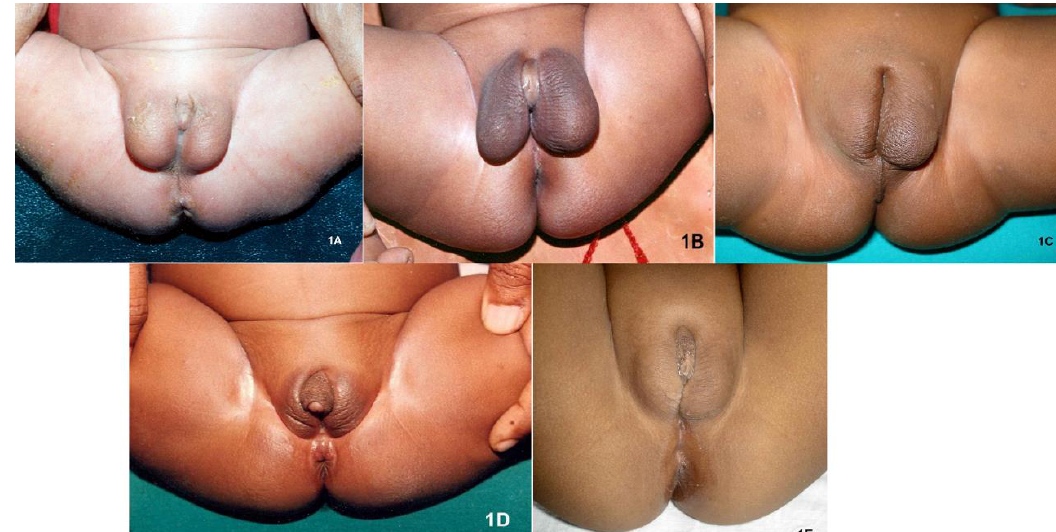
Figure 1: Appearance of external genitalia is no guide to assignment of sex in neonates. Despite similar appearance of the external genitalia the diagnosis and management in each of them are significantly different. (1A). 5-alpha reductase deficiency (46XY, bilateral testes) requires male assignment as the penis will enlarge at puberty; (1B) Severe hypospadias is otherwise an established male in all aspects; (1C). High risk of cancer in mixed gonadal dysgenesis (left testis and right ovary) requires early gonadectomy and female sex assignment; (1D). Congenital adrenal hyperplasia (46XX, bilateral ovaries) is usually assigned to female sex but severe androgen imprinting may require male assignment; (1E). Complete androgen insensitivity syndrome (46XY, bilateral testes) requires female sex assignment due to poor androgenization of body and brain; gonadectomy in them may be postponed until puberty to facilitate development of secondary sexual characters.